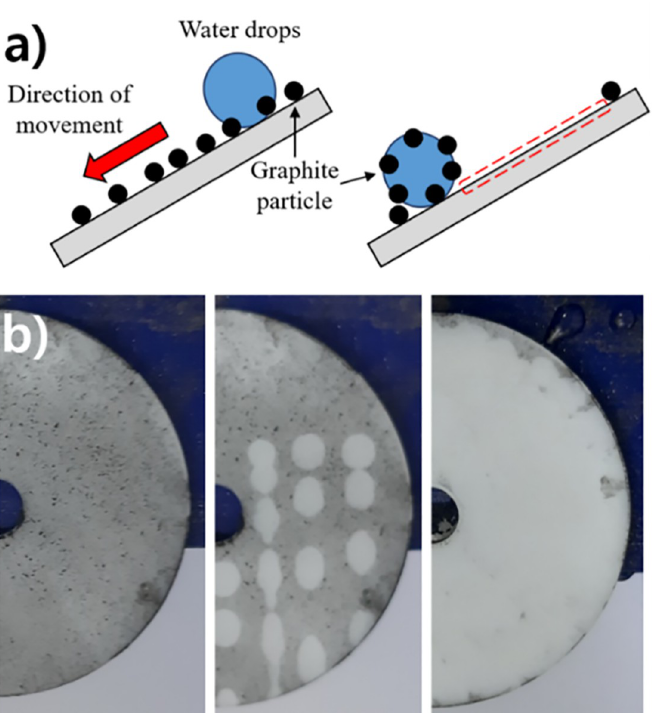
Fig 5. Verifying the self-cleaning effect of the produced specimen. (a) The process of removing fine contaminants from the manufactured specimen. (b) The process of removing contaminants from the treated specimen. The water droplets repeatedly bounced off the surface. In this process, particles in the path were removed, and finally, they were off the surface of the specimen. As a result of repeating the same process for 20 seconds, almost all particles on the surface were removed, and only a few particles remained in the place where water droplets did not